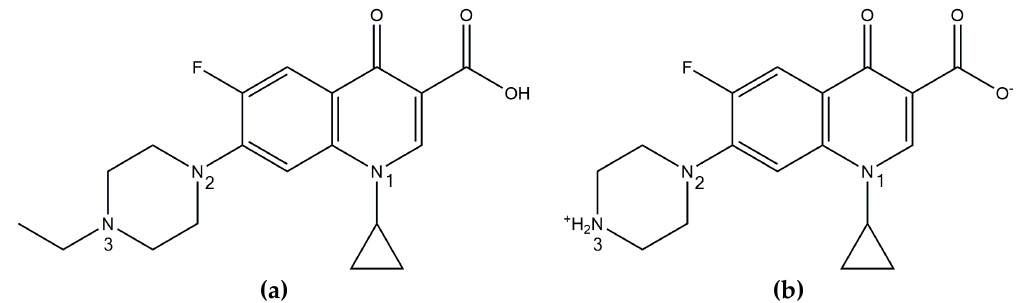
Figure 1. Chemical structure of ( a ) enrofloxacin and ( b ) ciprofloxacin.